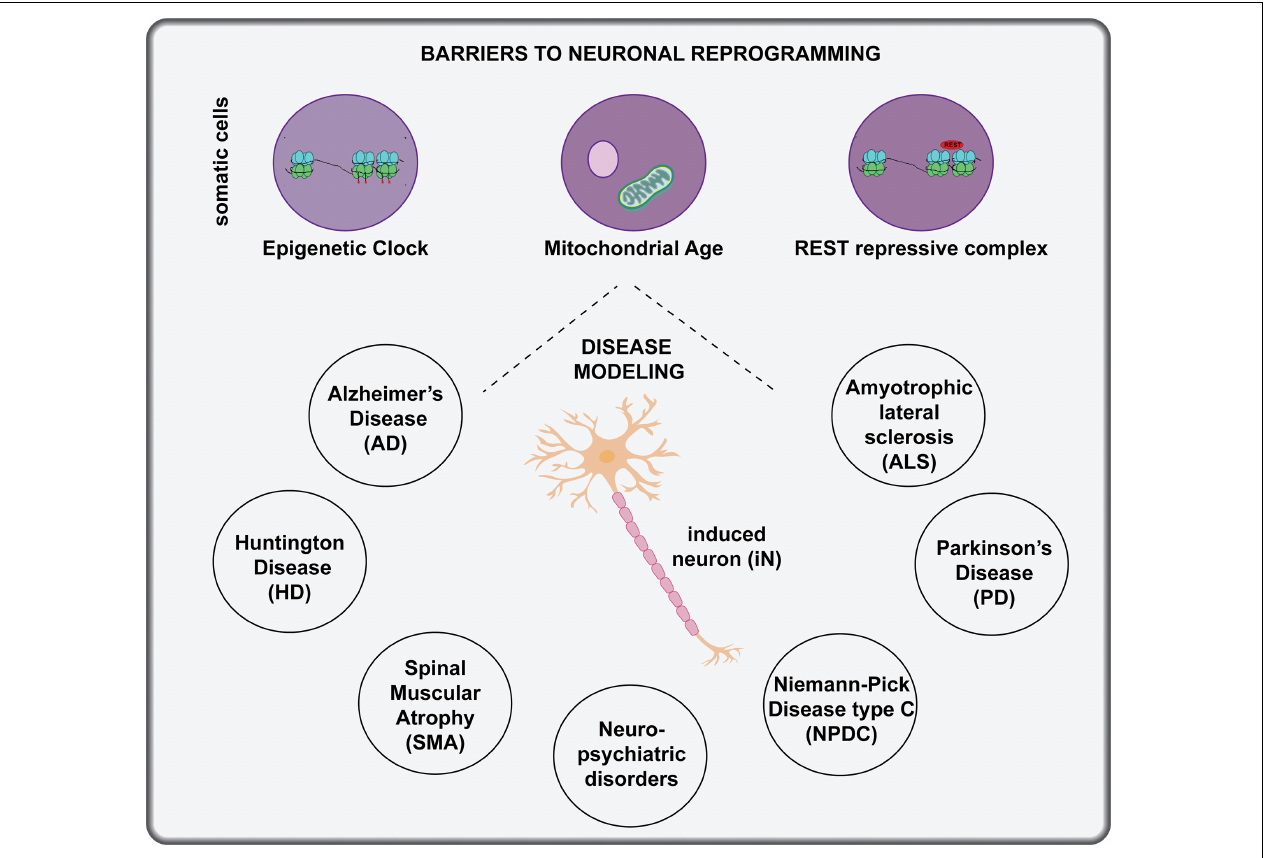
FIGURE 5 | Applications of in vitro direct neuronal reprogramming. The generation of iNs in a dish has great potential for disease modeling, but several considerations must be made when using host cells from aged individuals, including changes to the epigenetic clock, mitochondrial age and activity of the REST repressive complex. Diseases that have been modeled with in vitro neuronal lineage conversion beginning with patient cells include AD, ALS, PD, HD, Niemann-Pick disease type C, and neuro-psychiatric